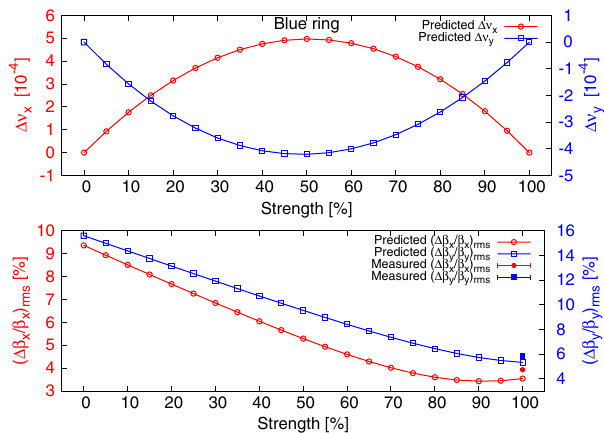
FIG. 3. Simulated evolution of tunes and rms beta-beat along a ramp-up process of the computed correction for the Blue ring. The measured rms beta-beat with error bars at 100% correction strength is also shown.